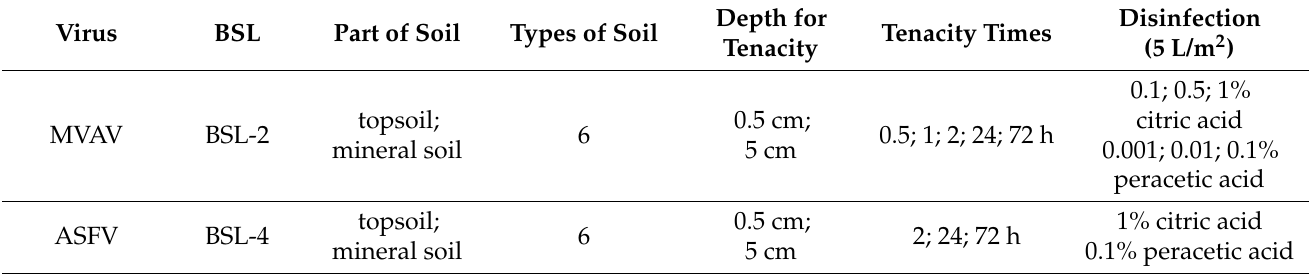
Table 1. Experiment